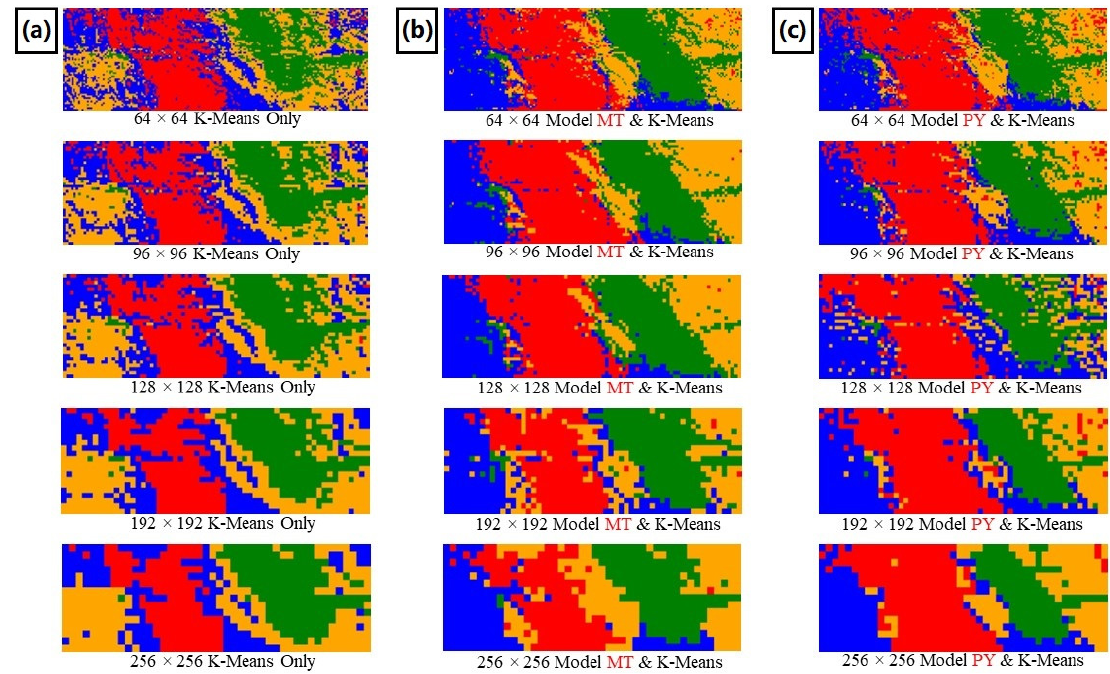
Figure 8. Coloured cluster maps of the Top Pit pit wall orthomosaic. Colour assignment of the cluster groups was based on visual comparison to the ground truth in terms of spatial correspondence. the autoencoder-first (Model PY) K-Means clustering map. Table 7. Tile accuracies of the unsupervised learning methods for Top Pit.